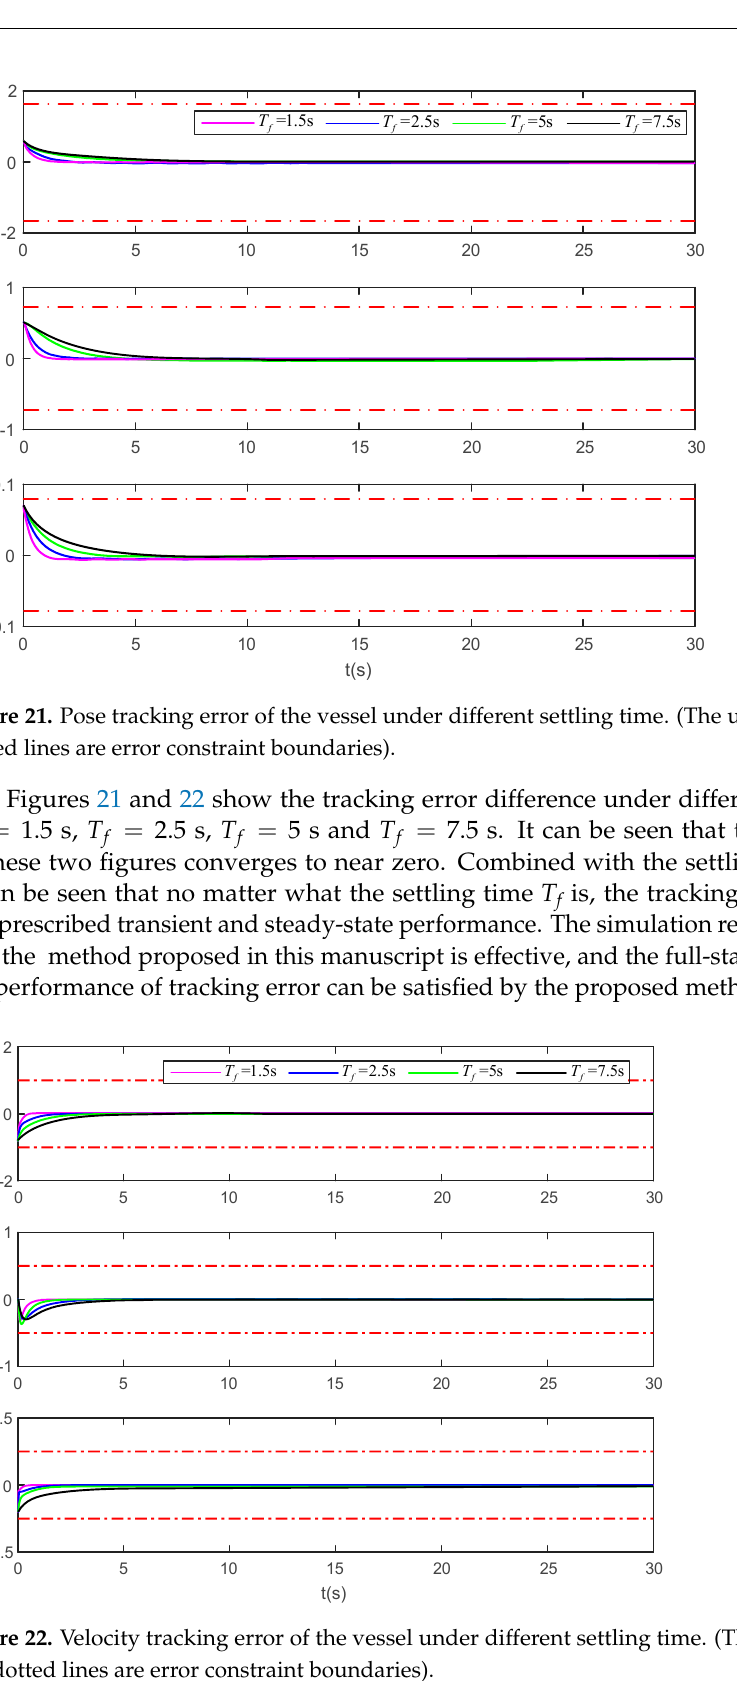
Figure 22. Velocity tracking error of the vessel under different settling time. (The upper and lower red dotted lines are error constraint boundaries).